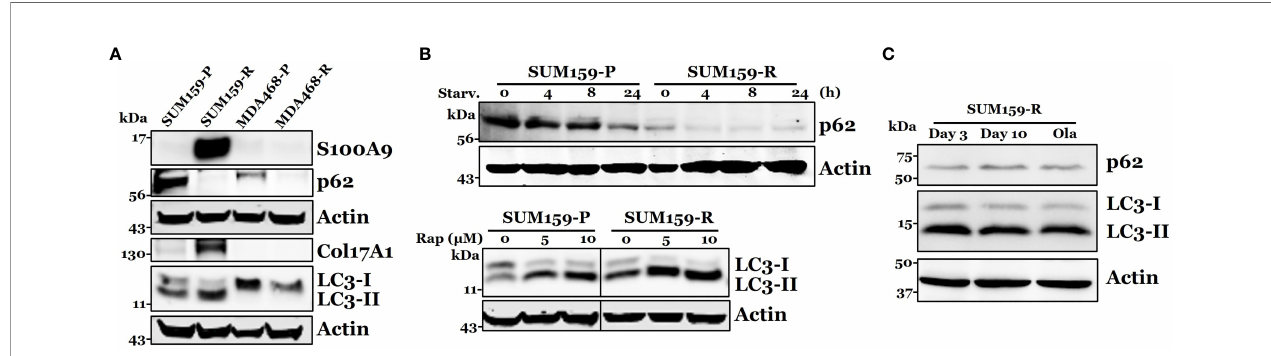
FIGURE 5 | Con fi rmation of S100A9, p62, COL17A1, and LC3 expression in olaparib resistant cells. (A) Western blot analysis of S100A9, p62, COL17A1, and p62 associated protein LC3-I, II in both parental and resistant SUM159 and MDA468 cells. (B) Effect of autophagy stimulation on p62 and LC3 expression. Parental and resistant SUM159 cells were starved for indicated periods (upper panel) or treated with two different doses (5 µM and 10 µM) of rapamycin for 24 hrs (lower panel). The levels of p62 or LC3 were measured by western blotting. Rap, rapamycin and starv, starvation. (C) Effect of olaparib withdrawal on LC3 and p62 levels. SUM159-R cells were maintained in olaparib-free media for 3 days and 10 days or in olaparib-containing (25 µM) medium (ola).). P, parental; R, resistant; Starv., starvation; Rap, rapamycin; and